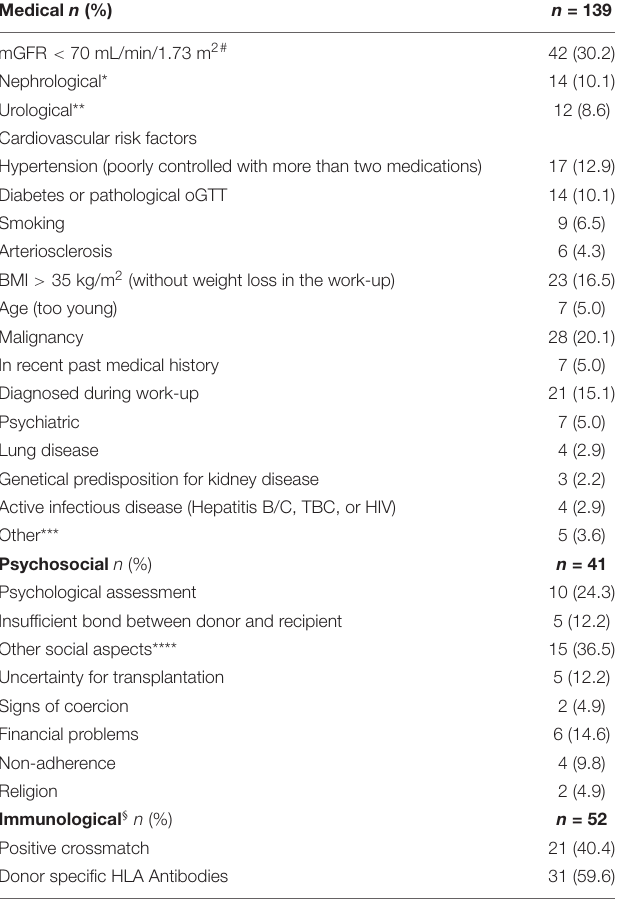
TABLE 4 | Donor-related reasons for disqualification from the LKD program. TABLE 5 | Baseline characteristics of recipients from disqualified donors and recipients who underwent LKD.